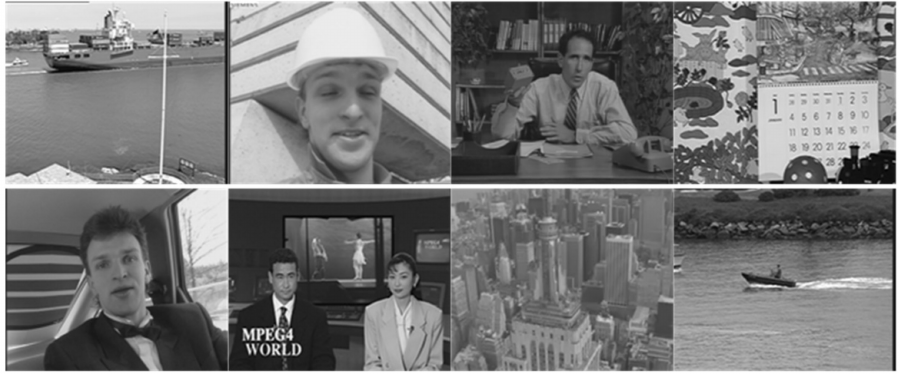
Figure 5. The original frames.